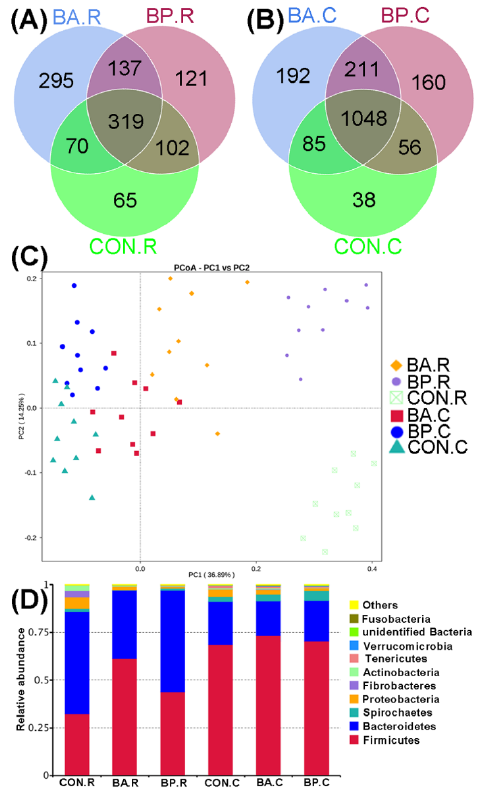
Figure 3. Venn and Principal Coordinates Analysis for microbial composition. ( A , B ) Venn diagrams for bacterial OTUs (Operational Taxonomic Units), ( C ) Principal coordinate analysis in terms of unweighted UniFrac metrics, and ( D ) Composition of microbial communities calculated at the phylum level. BA.R, BP.R, and CON.R indicate rumen content samples of BA-treated, BP-treated, and control groups, respectively; BA.C, BP.C, and CON.C indicate caecum feces samples of BA-treated, BP-treated, and control groups, respectively.